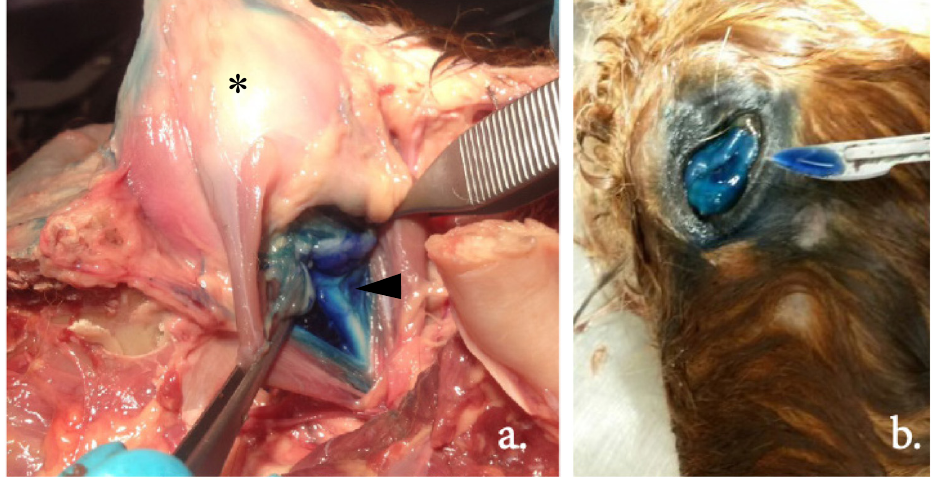
Figure 5. Methylene blue dye distribution at dissection of one of the equine cadaver heads in blue: ( a ) The dye was distributed in the periorbita (arrow head) with, centrally, the optic nerve visible; the asterisk indicates the eyeball.; ( b ) An example of intraocular dye in the eyeball.